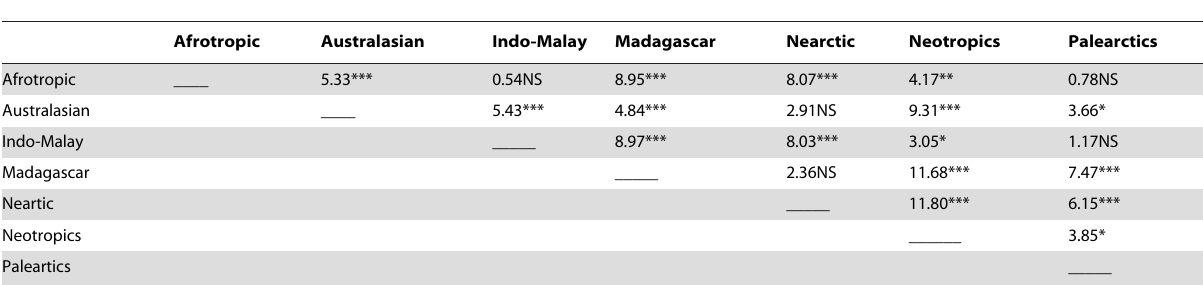
Table 3. Degree of climatic equilibrium for amphibians within the seven biogeographical